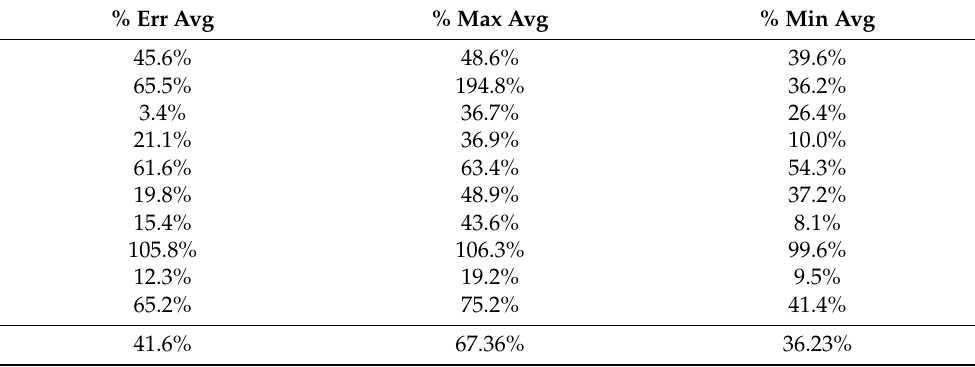
Table A40. Set 1, trials 21–30 data (single 0.5 PR value).